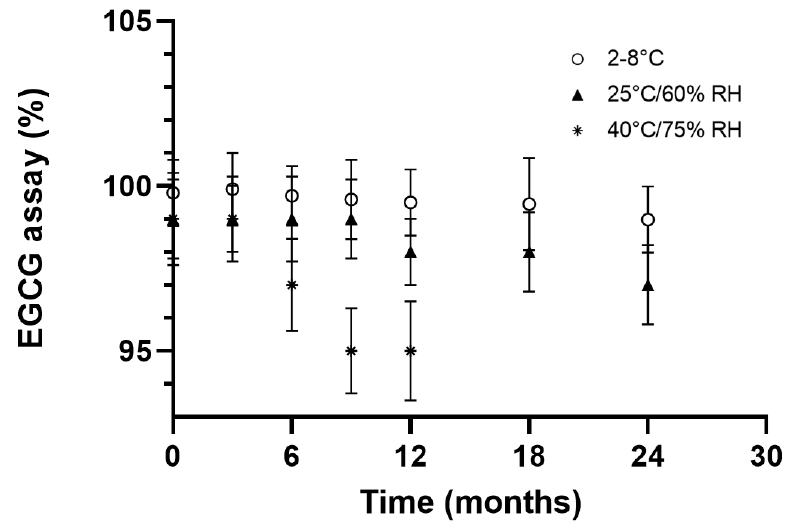
Figure 6. EGCG assay (%) as a function of time and storage conditions.